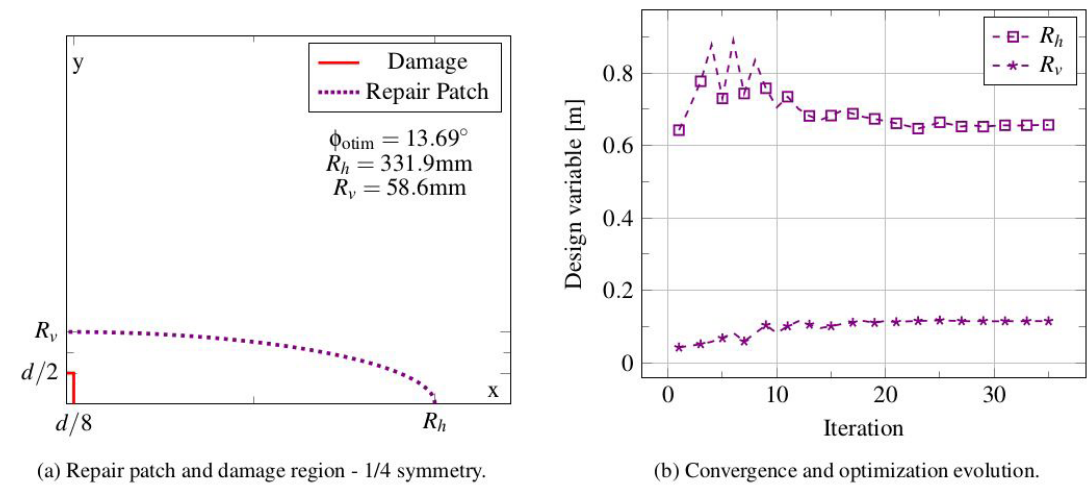
Figure 7. Elliptical repair patch - SS with an unsymmetrical stacking sequence.